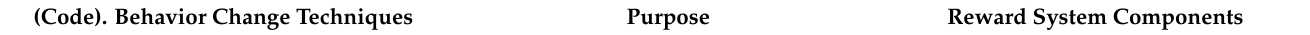
Table 1. List of the Behavior Change Techniques (BCTs) and their respective mediating purpose in our model. These BCTs are supposed to change behavior through motivation [6]. (Code). Behavior Change